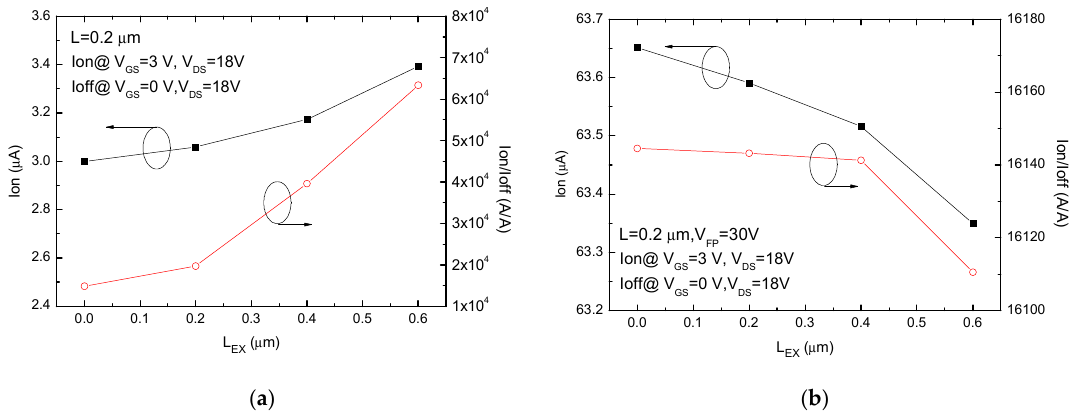
Figure 10. On-state current and I ON / I OFF ratio of W40 with various L EX at V DS = 18 V. ( a ) Gate field plate (GFP) and ( b ) V FP = 30 V.